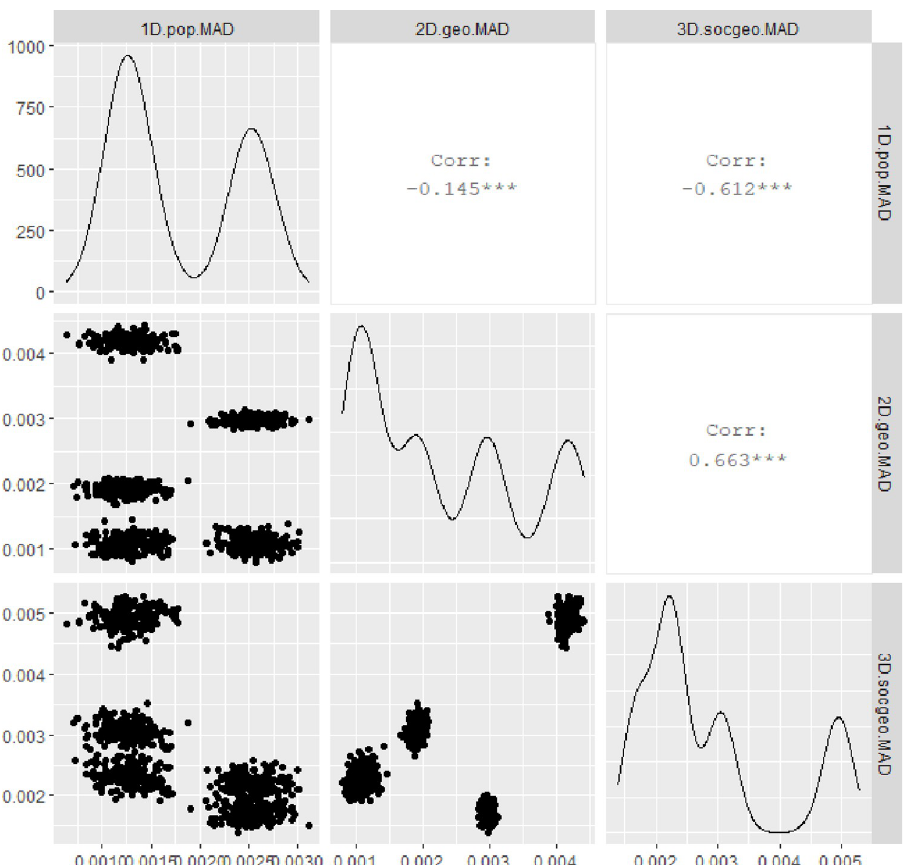
Fig 10. Relations in simulated data. Note: we analyse relations in simulated data between: a) MAD statistics for Benford conformity for 1D distances between population values ( MAD . pop . dist ),b) MAD statistics for Benford conformity for 2D distances between spatial points ( MAD . dist ), c) MAD statistics for Benford conformity for 3D distances between locations and population ( MAD . socgeo . dist ).Source: Own study with the use of GGally:: R package.